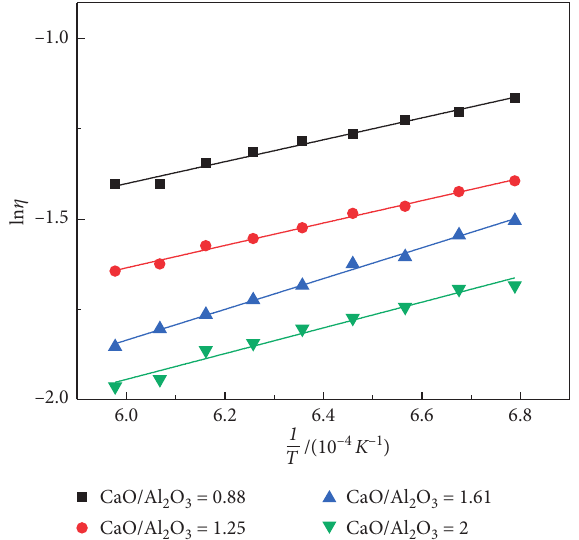
Figure 11: Plots of ln η versus T − 1 for fluxes with different CaO/ Al 2 O 3 ratios. Table 2: Melting temperature ( T m ), break temperature ( T b ), cor- rected optical basicity ( Λ corr ), and viscous activation energy of experimental slags. Slag no.